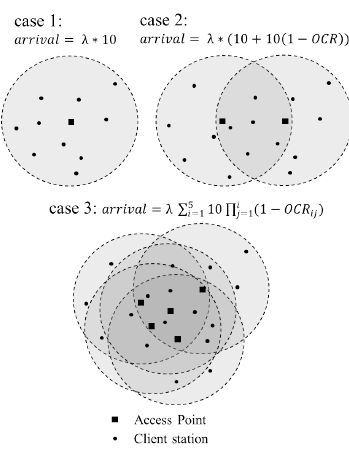
Figure 5. An example of network topology for queuing simulations.